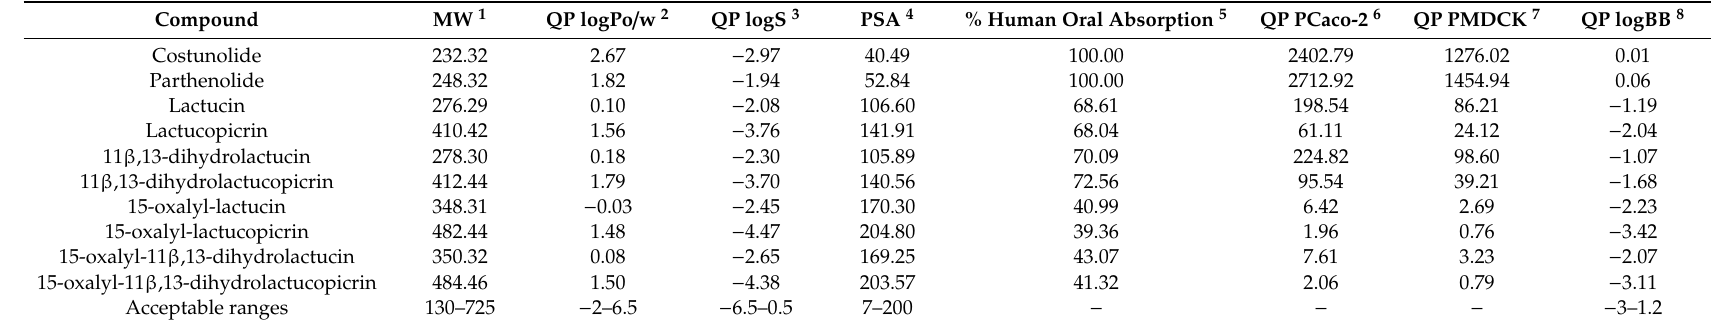
Table 2. In silico QikProp predicted parameters of passive membrane permeation for di ff erent